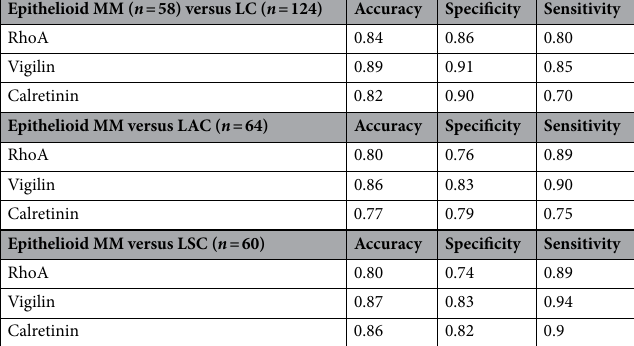
Epithelioid MM ( n = 58) versus LC ( n = 124)